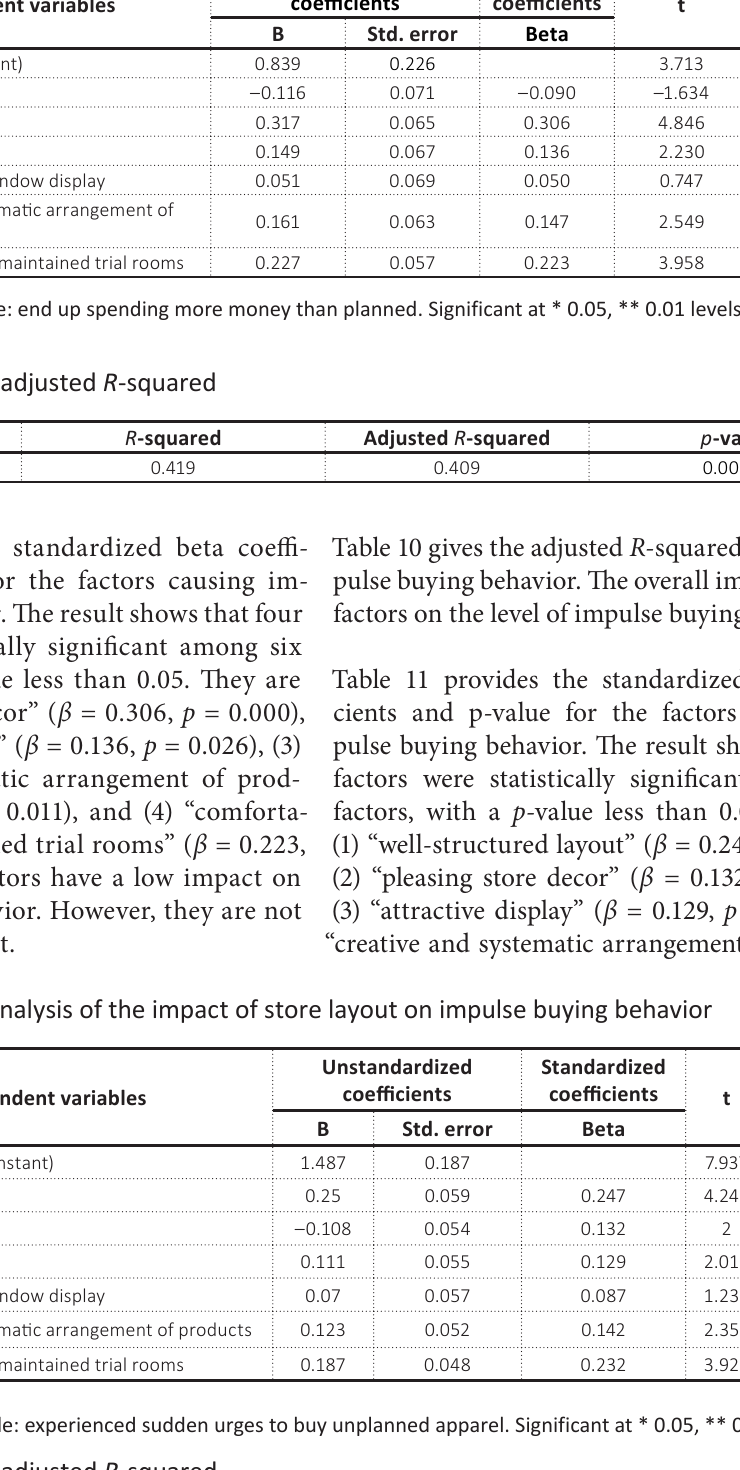
Table 12. Summary of adjusted R